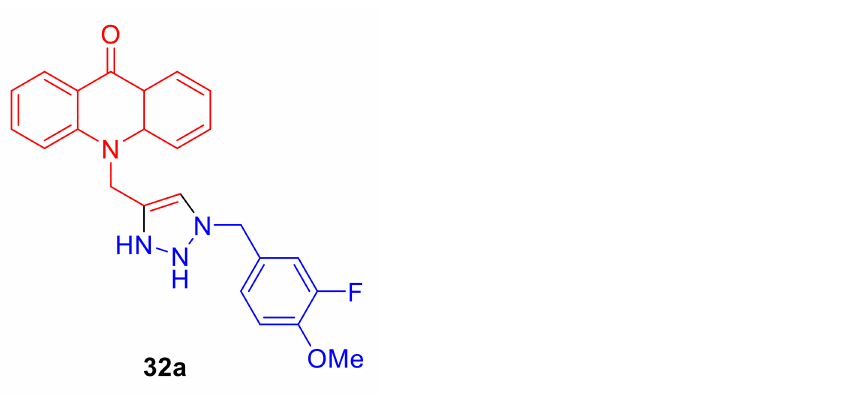
Figure 2. 1,4-DT with anticancer activity obtained in gram-scale through PcAAC.